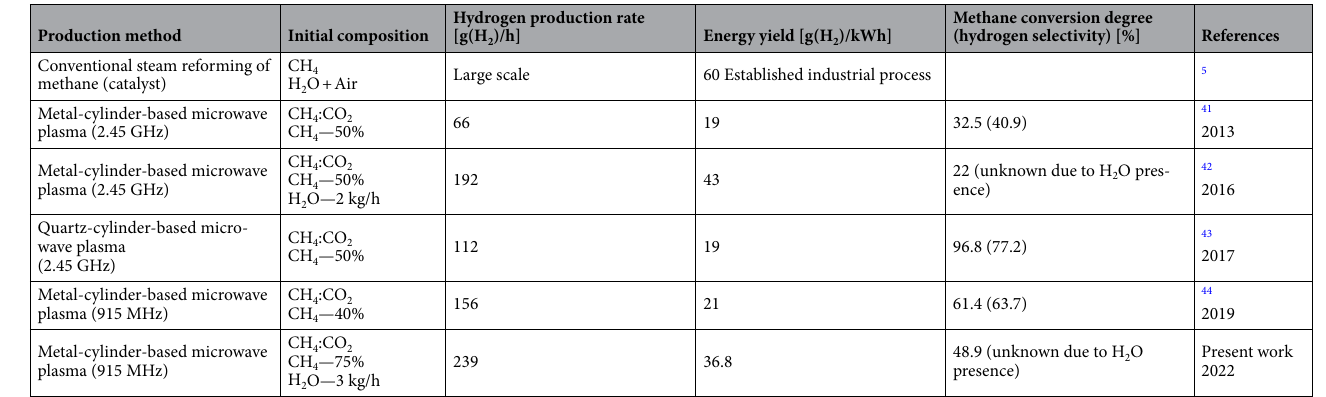
Table 4. Progress in microwave plasma technology for hydrogen production from synthetic